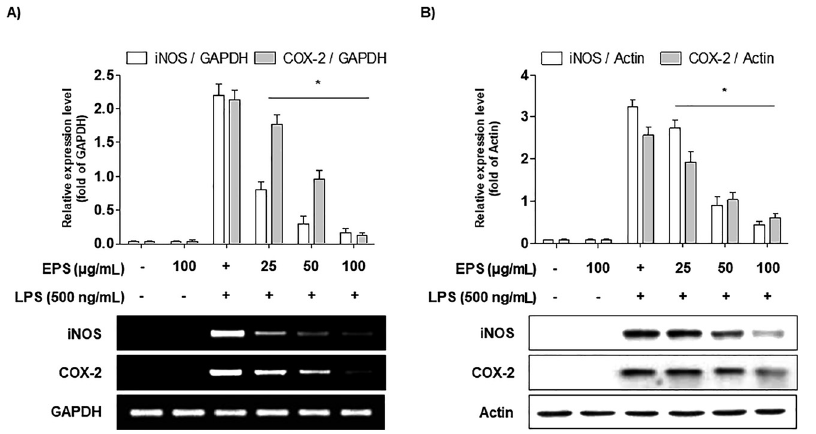
Figure 4: Down regulation of inducible nitric oxide synthase (iNOS) and cyclooxygenase-2 (COX-2) expression by EPS in lipopolysaccharide (LPS)-stimulated RAW 264.7